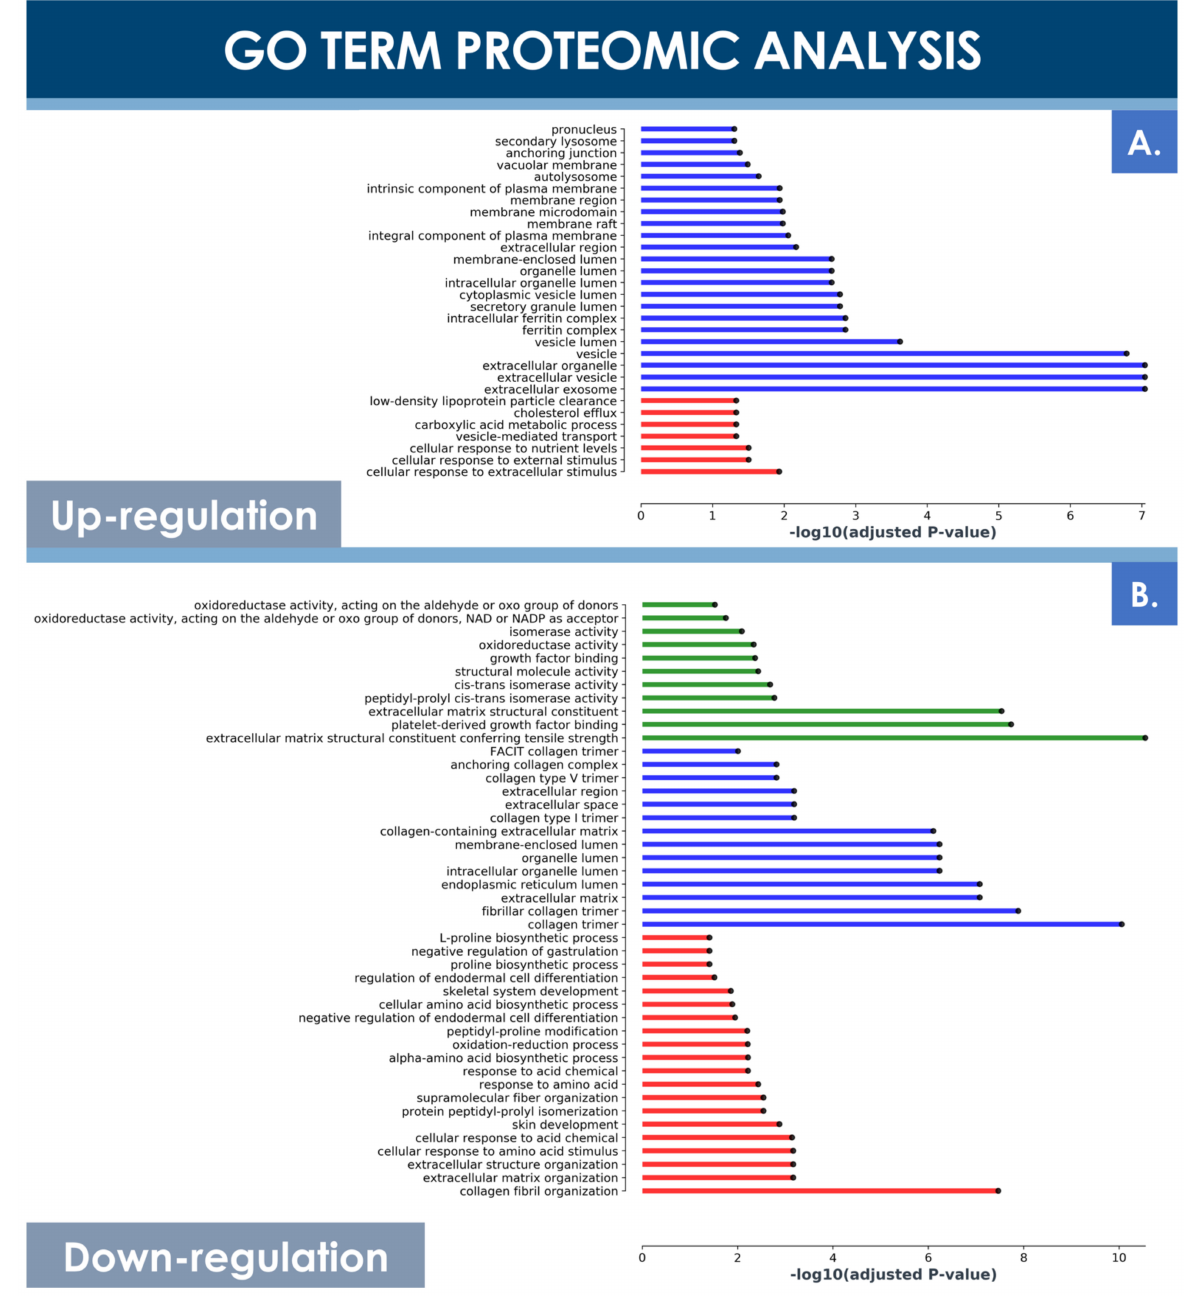
Figure 7. GO TERMS analysis of differentially expressed hFPT proteins in the hypoxia sample group as compared to the normoxia sample group, with a log significance threshold value specified at − 0.9 for downregulation and at 0.9 for upregulation and an FDR significance threshold value specified at ≤ 0.01. ( A ) Upregulated protein GO TERMS. ( B ) Downregulated protein GO TERMS. Identified hits with relevant changes in detected levels were classified into three groups, namely “cellular compartment” (i.e., in blue), “molecular function” (i.e., in green), and “biological processes” (i.e., in red). FDR, false discovery rate; hFPT, human fetal progenitor